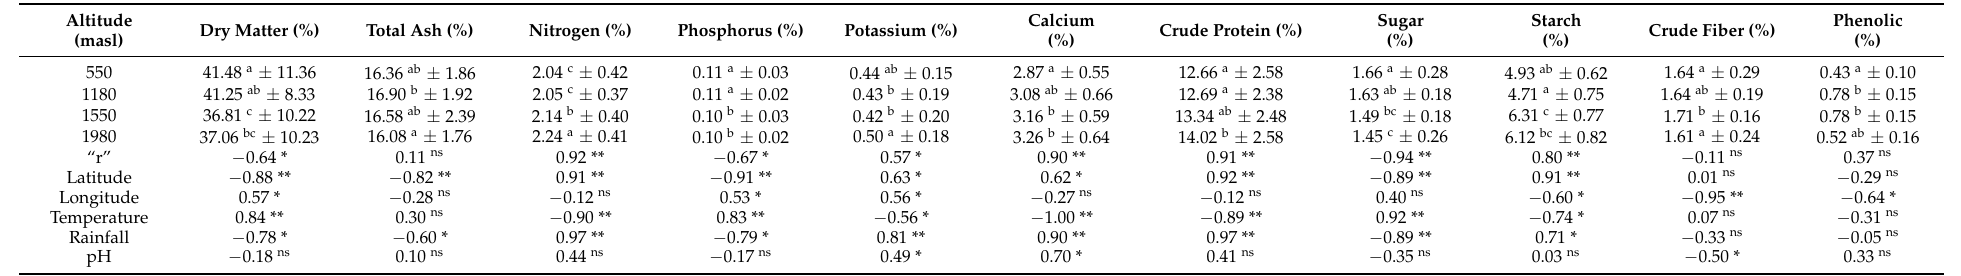
Table 2. Nutritive values of C. australis foliage as influenced by altitude, irrespective of seasonal variation ( ± SD); Means followed by the same letter are not significantly ( p < 0.05) different.